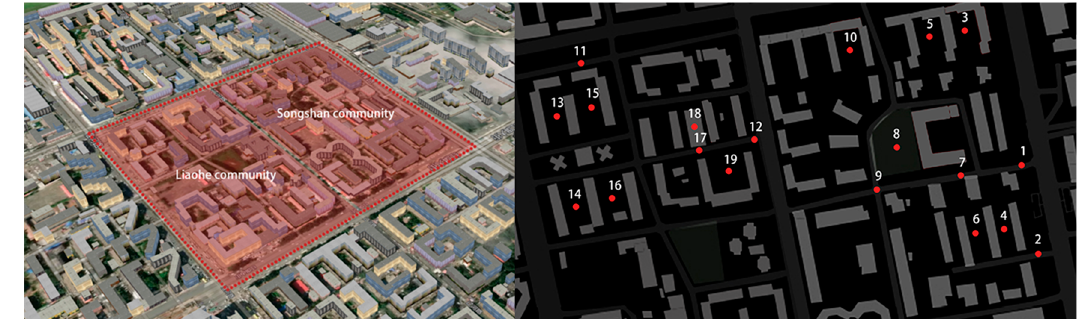
Figure 1. Layout of the study area and measurements of the points set.